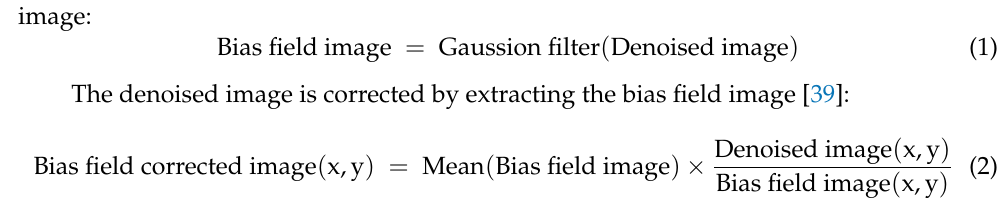
Figure 3. AO-SLO image ( a ) before and ( b ) after denoising using proposed method based on TV- L1 optical flow registration.